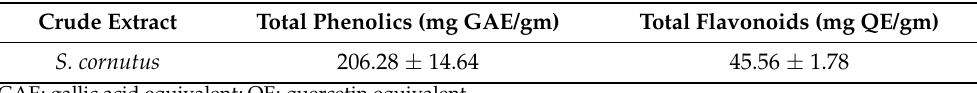
Table 2. Total phenolics and total flavonoids content in S. cornutus .